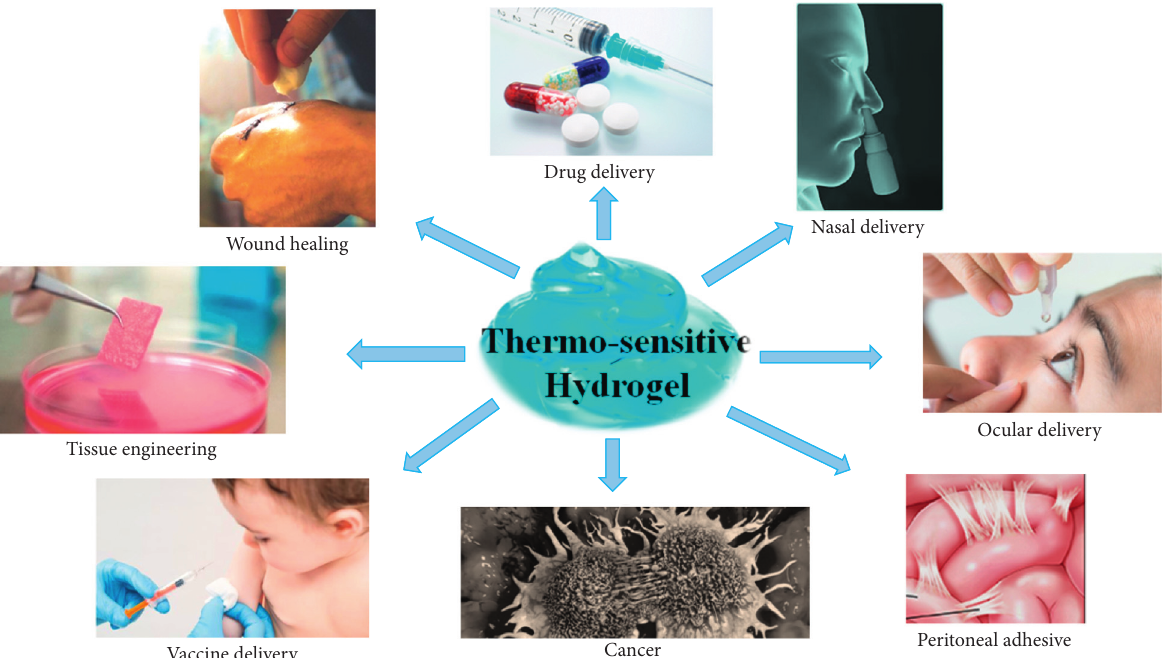
Figure 3: Applications of thermosensitive